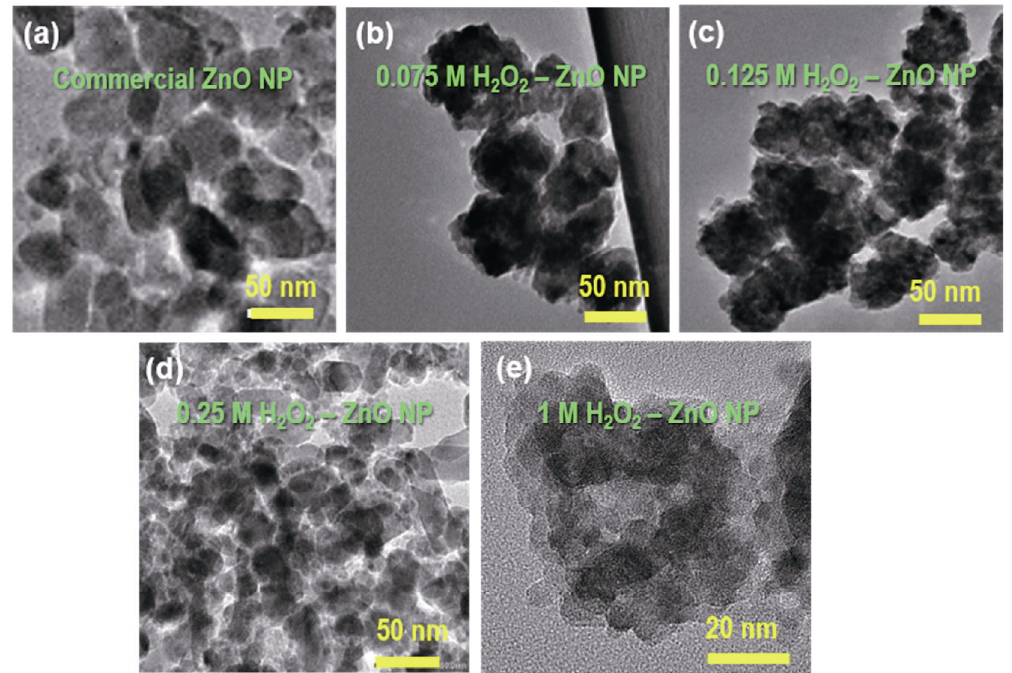
Fig. 4 TEM images of (a) commercial ZnO NPs, (b) 0.075 M H 2 O 2 treated/annealed ZnO NPs, (c) 0.125 M H 2 O 2 treated/ annealed ZnO NPs, (d) 0.25 M H 2 O 2 treated/annealed ZnO NPs, and (e) 1 M H 2 O 2 treated/annealed ZnO